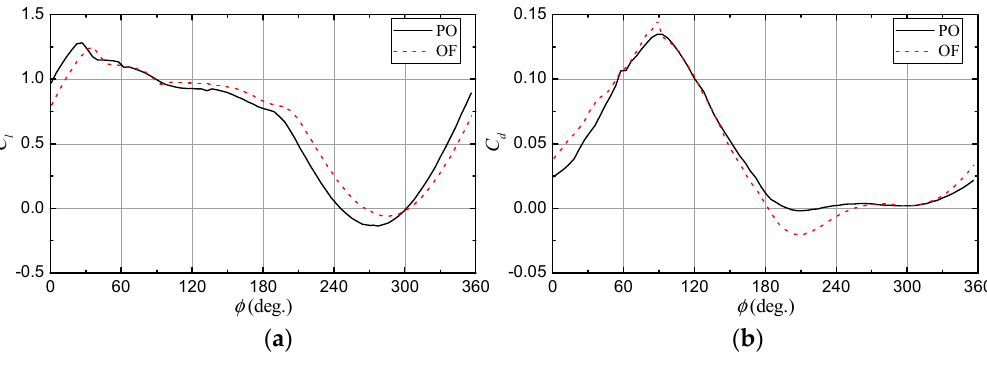
Figure 11. Comparison of lift coefficient and drag coefficient between pitch oscillation and oscillating freestream. α m = 8°, A = 10°, and k = 0.026. ( a ) The lift coefficient; ( b ) The drag coefficient.